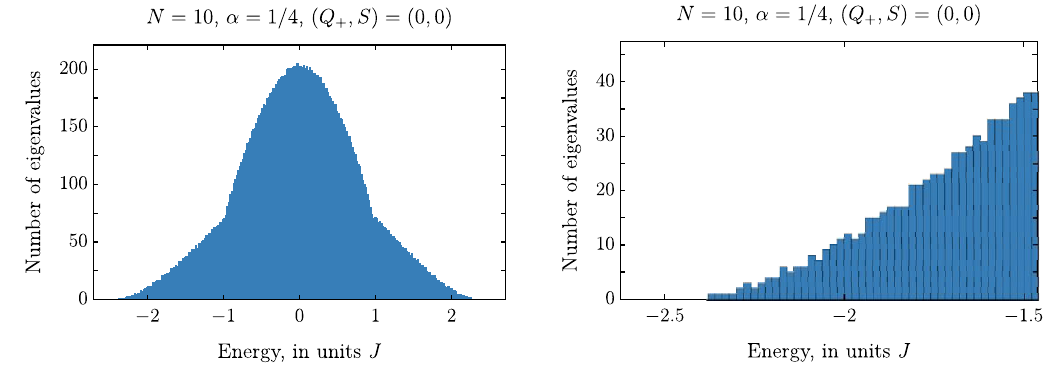
Figure 13 . Density of states in the ( Q + , S ) = (0 , 0) sector for a single realization at the U(2) symmetric point α = 1 for N = 10 . The ground state is in this U(2) invariant sector. On the right 4 we enlarge the region near the ground state; this shows that there is no significant